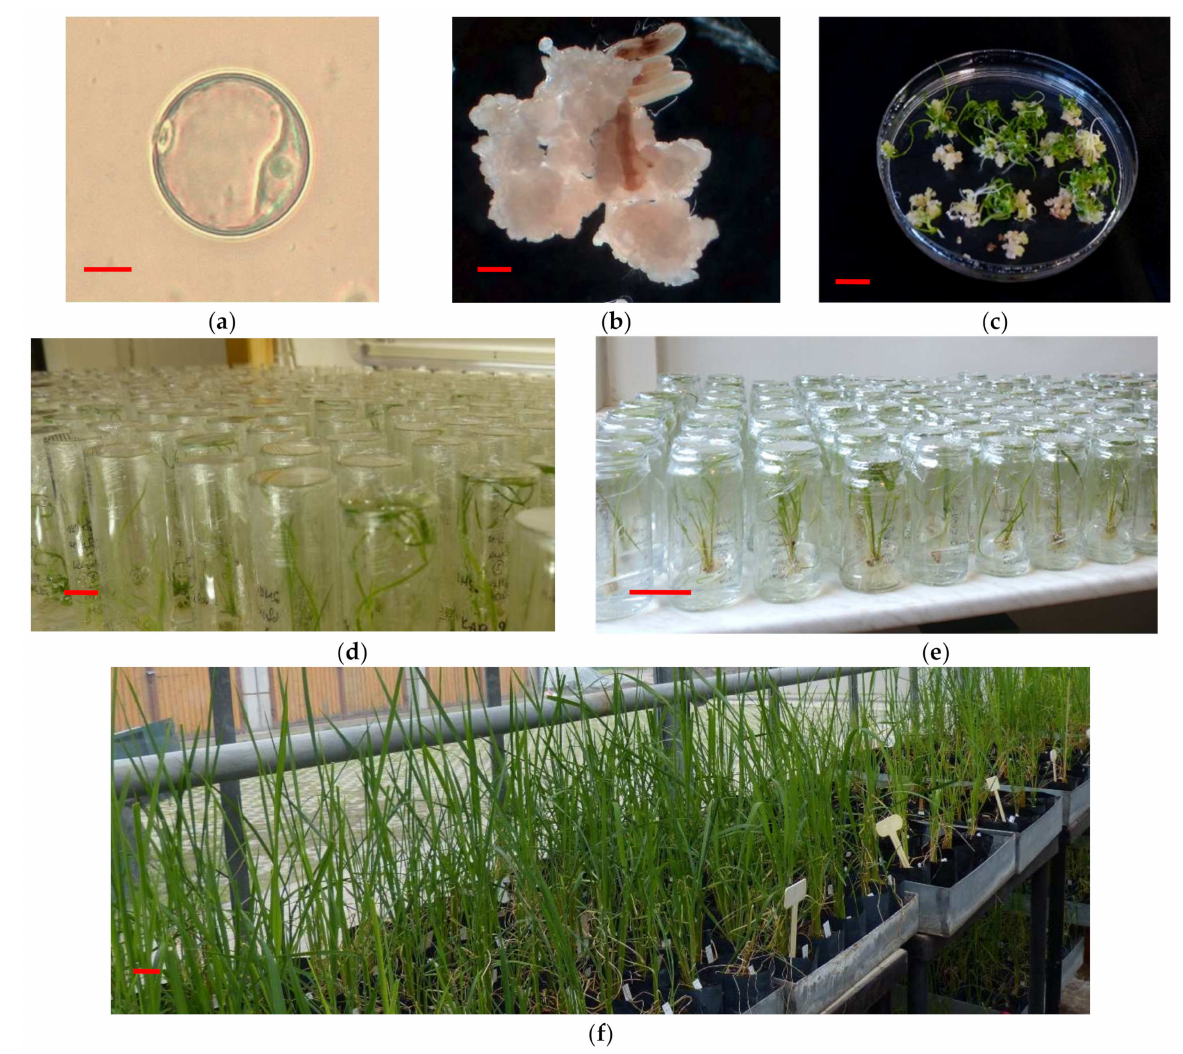
Figure 1. The AC of rice: ( a ) uninucleated microspore, ( b ) microspore-derived calli in AC of rice. ( c ) Plant regeneration of AC-derived calli from a high responding genotype. ( d ) Rooting of AC derived green plantlets in individual tubes. ( e ) Developing green plantlets in individual jars. ( f ) Acclimatized plants in the glasshouse. Bars = 10 µ m for ( a ); 1 mm for ( b ); 10 mm for ( c ) and ( d ); 50 mm for ( e ) and ( f ). Table 1. Statistical analyses of the effect of growth regulators on the number of AC-derived calli. df MS of Calli/100 Anthers Growth regulators